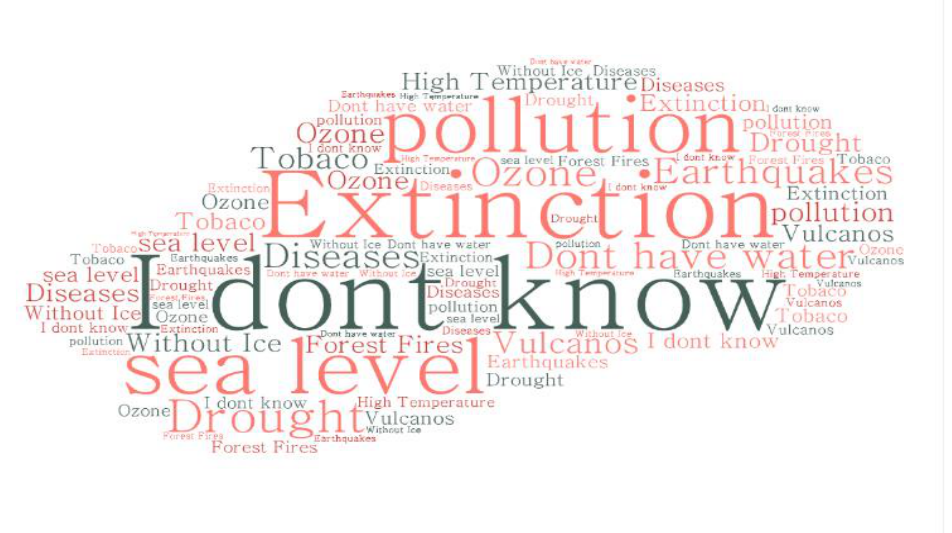
Figure 3. Word cloud on students’ responses to the question “List one consequence of climate change” n = 242.